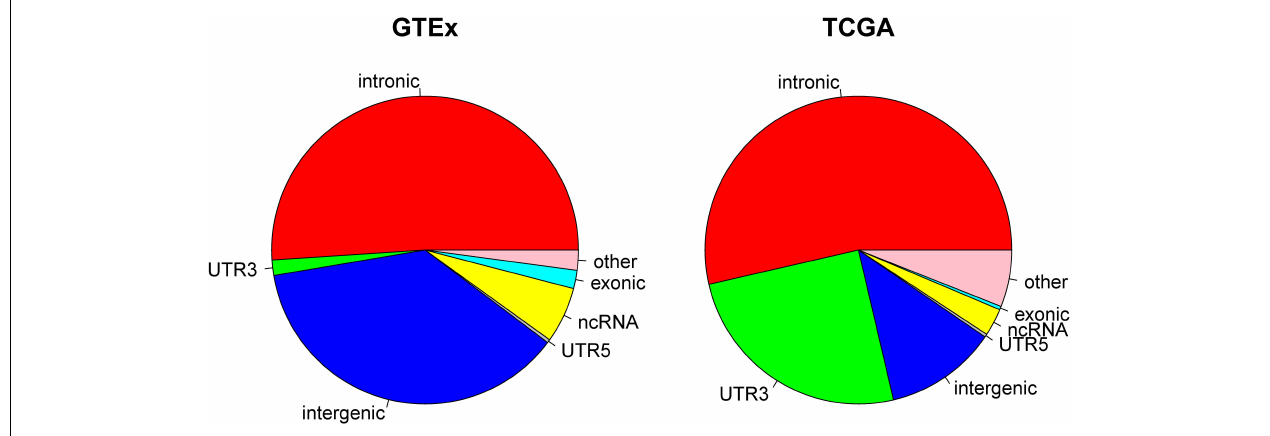
FIGURE 2 | Pie charts display the distribution of RNA editing positions by genomic location categories. Most of RNA editing happens in intronic regions. Large proportional differences can be observed between GTEx and